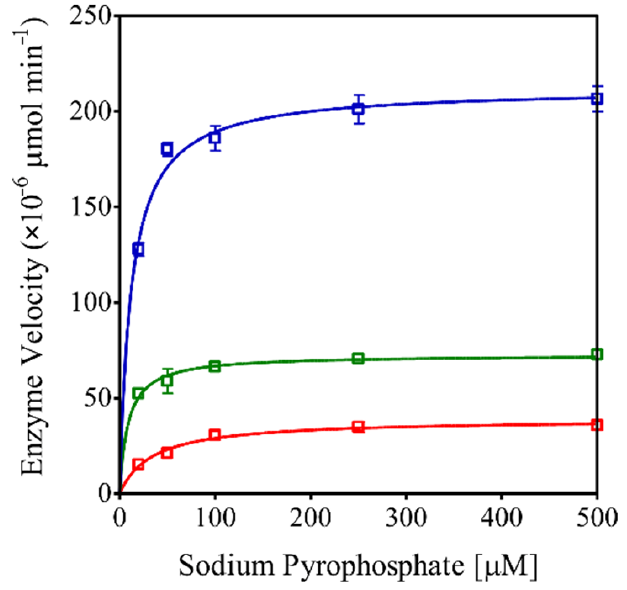
Figure 3. Effect of Na-PPi concentration on the r Eh HAPp49 enzyme velocity. PPase activity as a function of pH 5.0 (red), 7.0 (green), and 9.0 (blue). Bars represent the standard error ( n = 3). Table 2. Michaelis–Menten kinetic parameters of the pyrophosphatase activity of r Eh HAPp49.